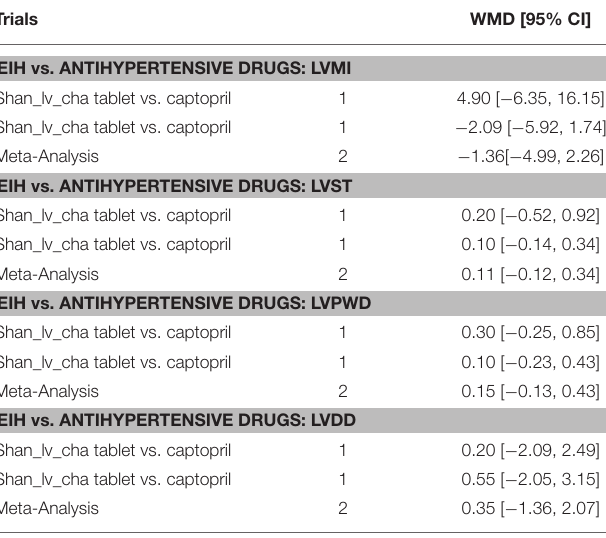
TABLE 7 | Analyses of left ventricular